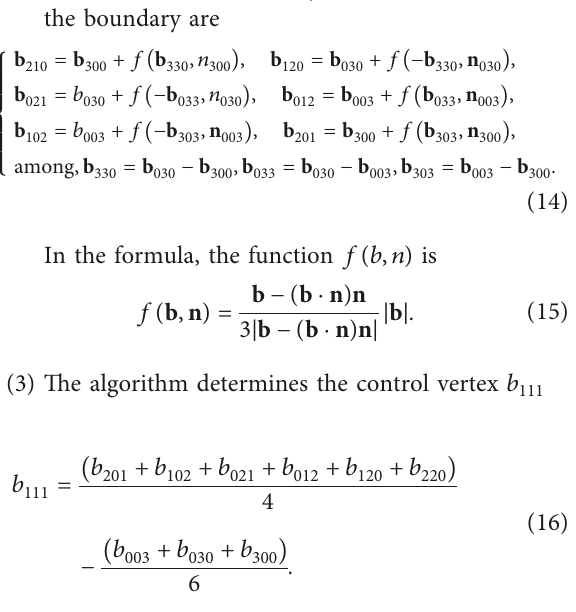
Figure 7: Vertices and their adjacent triangle